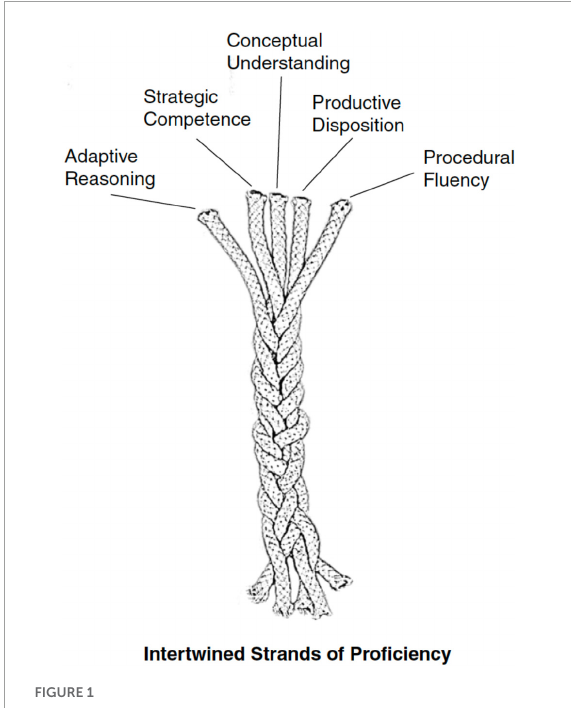
FIGURE1 Intertwinement of different learning goals and the particular role of conceptual understanding (Kilpatrick et al., 2001, p.